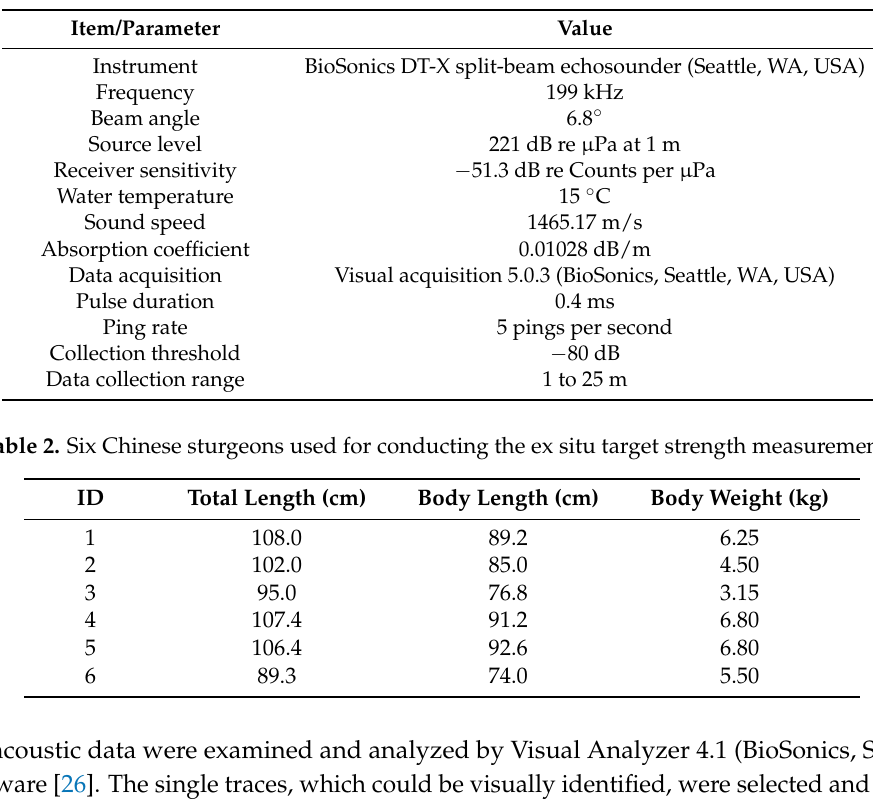
Figure 2. The ex situ TS measurements of Chinese sturgeons in a net cage base in the Yangtze River: ( a ) the test specimen; ( b ) the net cage; and ( c ) the echogram from the acoustic measurements by Visual acquisition 6.0.7 (BioSonics, Seattle, WA, USA). Table 1. Instrument and parameter settings for the ex situ target strength measurements.